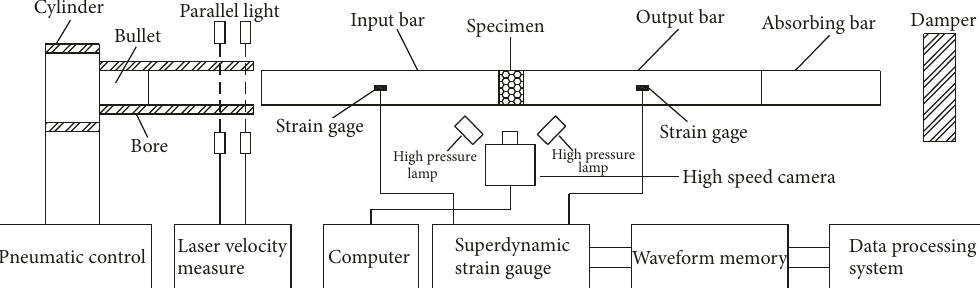
Figure 1: Diagram of SHPB experimental system.